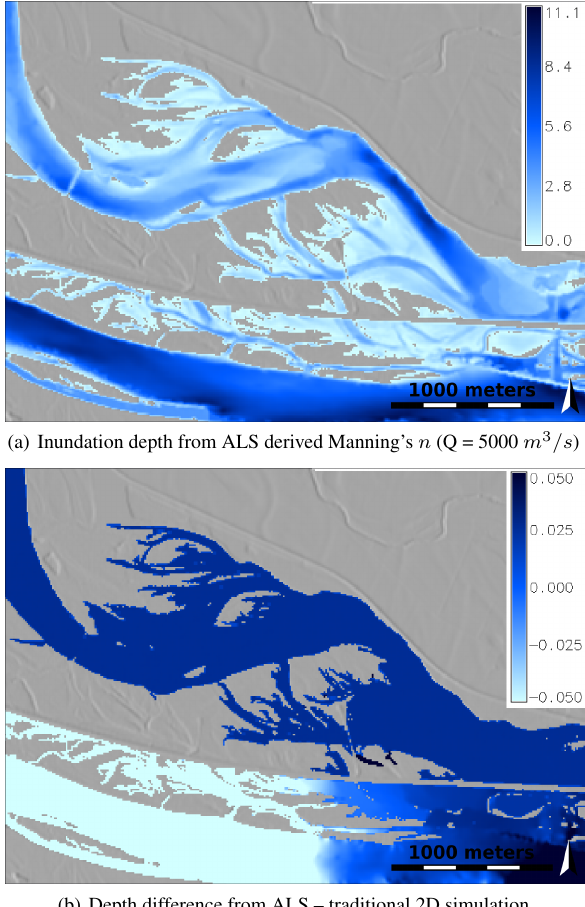
Figure 4: Depth of inundated area and difference model from 2D simulation based on the same boundary conditions for ALS and traditional derived Manning’s n [ m